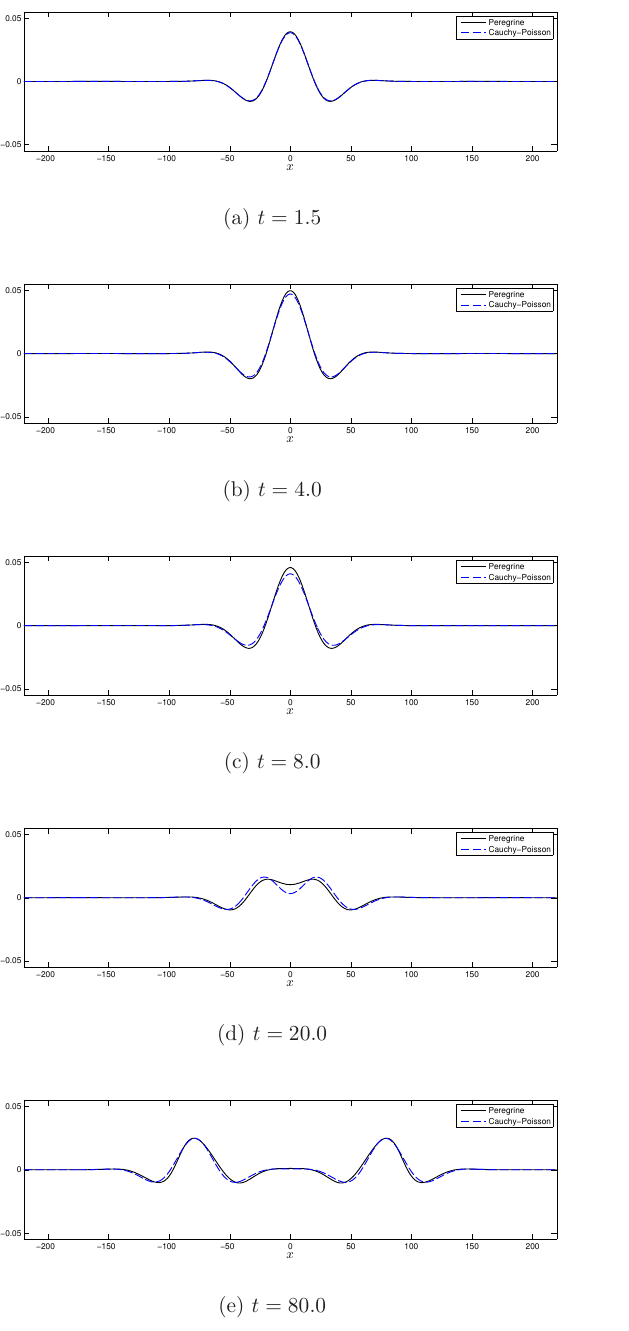
Fig. 10. Free surface waves generated by a fast bottom motion. The Fig. 9. Free surface waves generated by a moderately fast bottom Figure 10. Free surface waves generated by a fast bottom motion. The blue Figure 9. Free surface waves generated by a moderately fast bottom motion. The blue dashed line corresponds to the analytical Cauchy–Poisson so- motion. The blue dashed line corresponds to the analytical Cauchy– dashed line corresponds to the analytical Cauchy–Poisson solution, blue dashed line corresponds to the analytical Cauchy–Poisson solu- lution, while the solid black line is our numerical solution to the Poisson solution, while the solid black line is our numerical solution while the solid black line is our numerical solution to the Peregrine tion, while the solid black line is our numerical solution to the Pere- Peregrine system. The time snapshots are taken at t = 2 . 5, t = 8, to the Peregrine system. The time snapshots are taken at t = 1 . 5, system. t = 15, t = 25, and t = 70, from top to grine system. t = 4, t = 8, t = 20, and t = 80, from top to bottom.